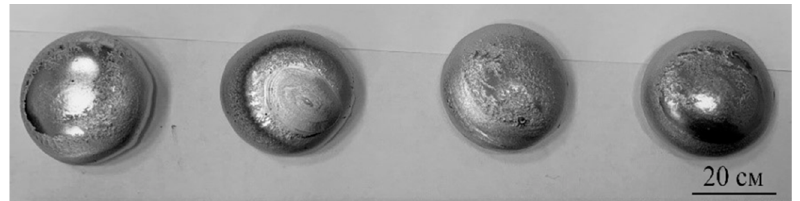
Figure 1. The resulting ingots weighing 45–50 g.